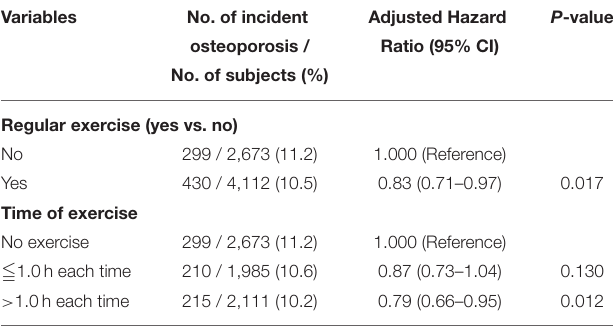
TABLE 5 | The relative risk for incident osteoporosis in the longitudinal cohort according to the presence of regular exercise ( N = 6,785) and time of exercise ( N = 6,769, excluding 16 subjects without data at hours per exercise